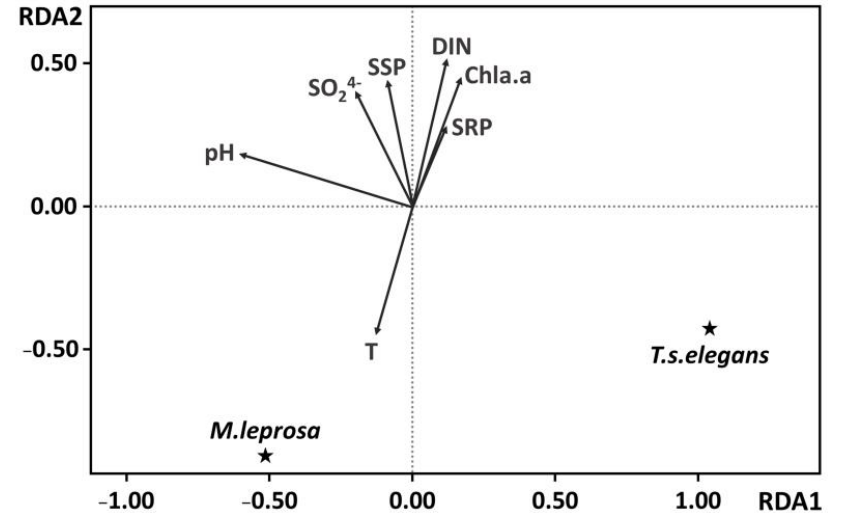
Figure 4. Biplot from redundancy analysis showing the relation of the species with the studied environmental variables. Environmental variables are represented by solid vector lines and their acronyms. Species are represented by stars and their name. T: temperature; SO 24 − : sulphates concentration; SSP: suspended solids; DIN: dissolved inorganic nitrogen concentration; Chla.a: phytoplanktonic chlorophyll- a ; SRP: soluble reactive phosphorous concentration.